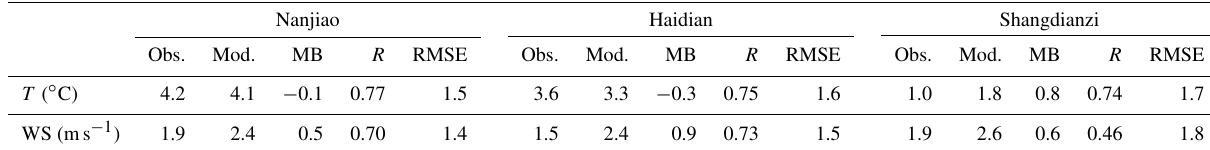
Table 1. Performance statistics between observed and simulated meteorology.